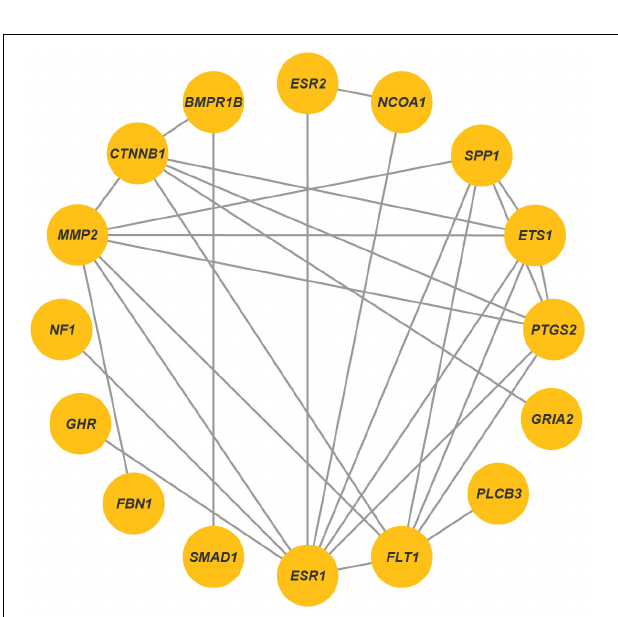
FIGURE 7 | Protein–protein interaction networks identified by using STRING database. Each line indicated known signaling pathways and protein